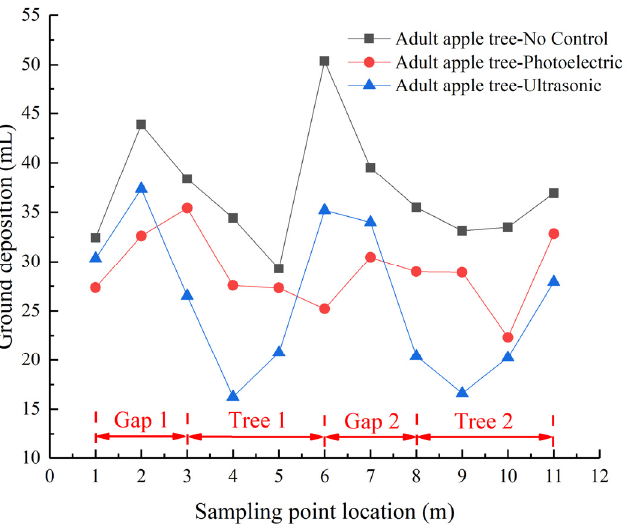
Figure 11. Distributions of ground deposition at the gap and tree positions of the adult apple trees.